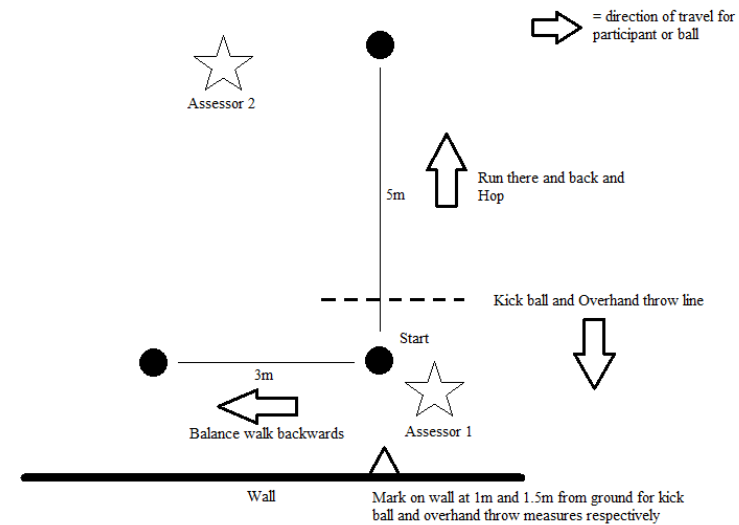
Figure 2. Layout of PLAYbasic assessment protocol for child level data collection.